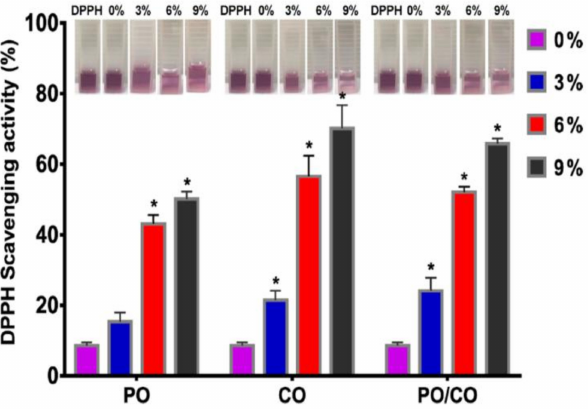
Figure 15. Different concentrations (0%, 3%, 6%, and 9%) of essential oil (PO, CO, and PO/CO)- containing nanofibers’ DPPH radical scavenging activity and the corresponding images of DPPH solution accommodating different nanofibers. * p < 0.05 versus the control group. Results are the mean ± SD ( n = 3). Reproduced from [262] with copyright permission from the American Chemical